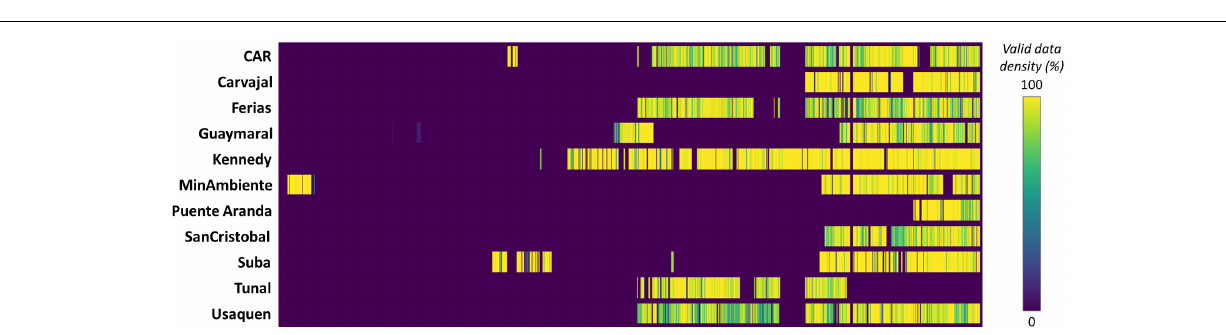
FIGURE 3 | Results of data validation, per station and validation rule, for PM 2 . 5 and PM 10 observations.